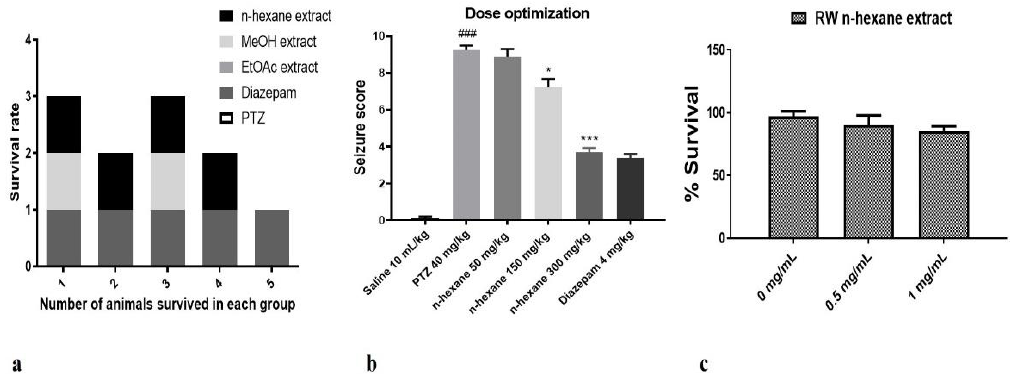
Figure 1. ( a ) Survival rate of animals (n = 5) in each group treated with PTZ, ethyl acetate, methanol and n -hexane extracts of fruit of Rosa webbiana . No animal could survive in case of ethyl acetate and PTZ, while two animals survived in methanol extract and four in n -hexane extract and diazepam. ( b ) The seizure score observed at 50 mg/kg, 150 mg/kg and 300 mg/kg of n -hexane extract. The data were expressed as mean ± SEM. Symbol * indicates a significant difference from the PTZ group at p < 0.05, while *** indicates significant difference at p < 0.001; symbol ### shows a significant difference from saline at p < 0.001. ( c ) The cell survival fraction in MCF-7 cells (n = 3) in response to the n -hexane extract of fruit of Rosa webbiana (RW).